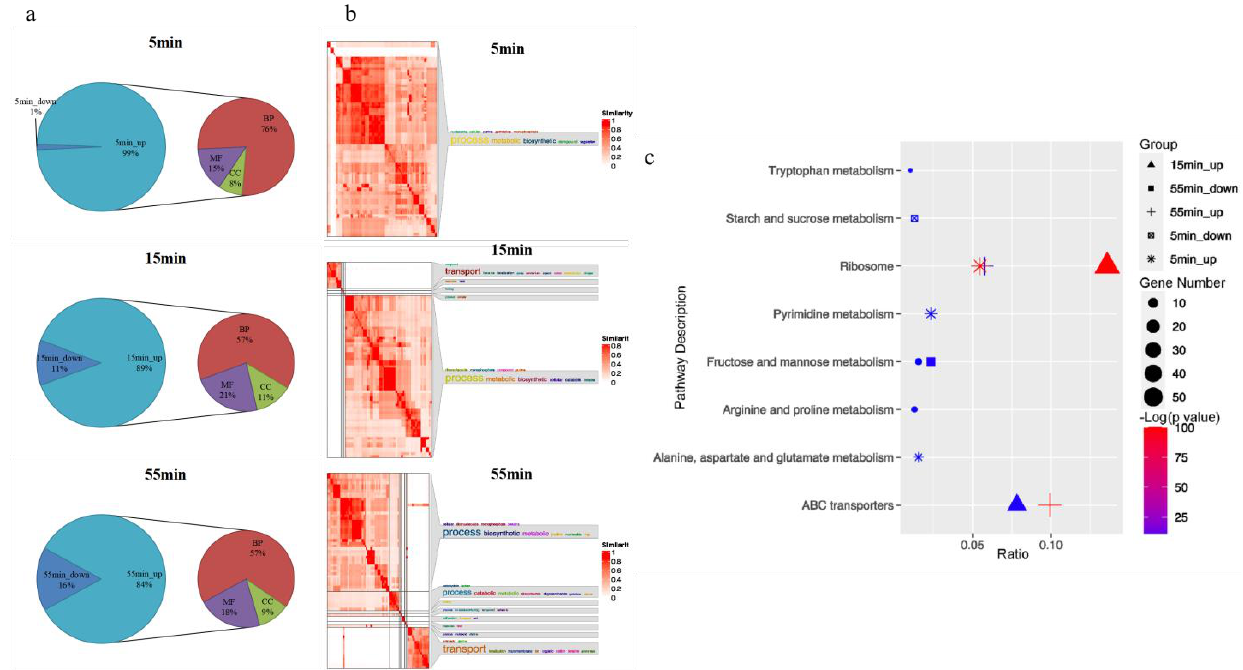
Figure 4. GO and KEGG analyses of host DEGs (upregulated and downregulated genes) enriched at selected points after SA1 infection. ( a ) GO analysis of the host upregulated and downregulated DEGs after phage SA1 infection. BP: biological process; CC: cellular component; MF: molecular function. ( b ) GO analysis for the biological processes of host downregulated DEGs. Terms representing each cluster are shown in a word cloud, with the size of the term representing the frequency of occurrence in the terms. ( c ) KEGG categories of host DEGs (up- and downregulated genes) enriched at selected points after SA1 infection. The shape of the point indicates the timepoints. The enrichment p -value of each pathway is shown as a color gradient. The size of the points represents the number of genes enriched in each pathway.